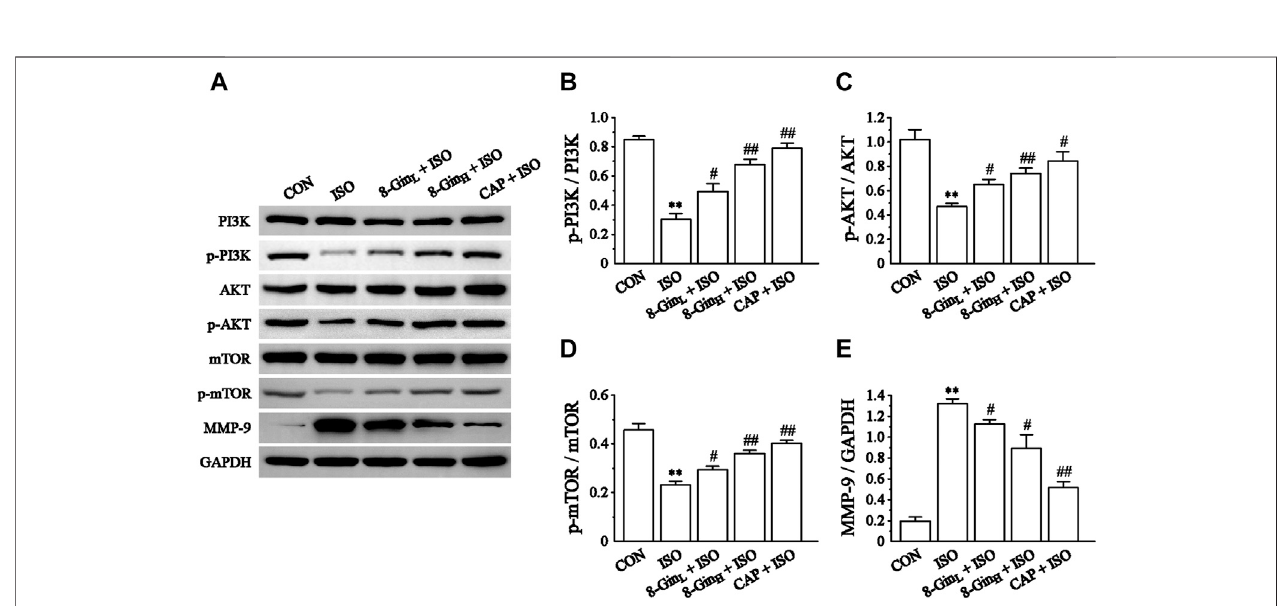
FIGURE 7 | Effects of 8-Gin on the formation of autophagosome in mice after MF. The number of autophagosomes were shown in myocardial tissues by TEM (indicated by arrow, scale bar (cid:1) 500 nm).